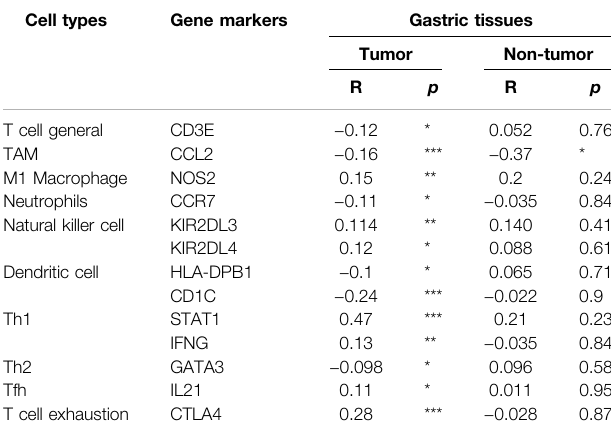
TABLE 3 | Correlation between ARHGAP11A and related immune markers in